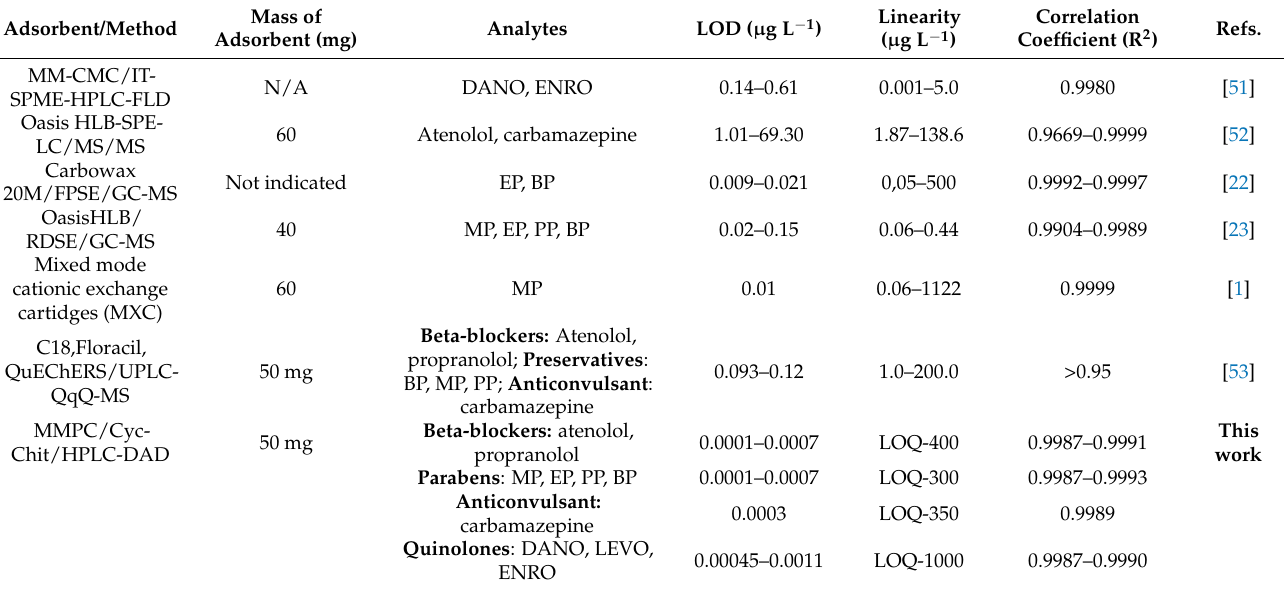
Table 3. Comparison of the present study with other solid-phase extraction methods for analysis of multi-class pollutants. Adsorbent/Method